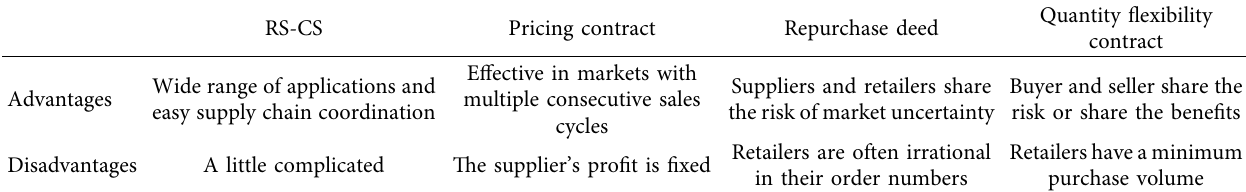
Table 5: Advantages and disadvantages of the proposed method versus the traditional